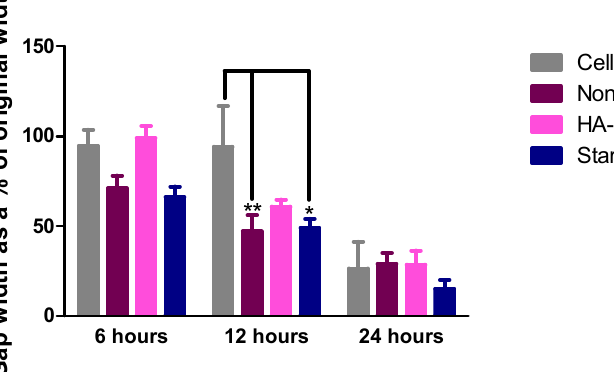
Figure 9. Cell migration assessed via gap closure achieved on a scratch assay. ( a ) Microscopy images of the gap area 12 h following addition of treatments, fresh, non-encapsulated Stromal-Derived Factor 1 α (SDF), HA–TA supernatant or SDF released from star-poly(glutamic acid) (PGA)–SDF(50:1)-HA–TA. Scale bar = 100 µ m ( b ) Quantification of gap closure showing the best gap closure achieved by star-PGA–SDF(50:1)-HA–TA supernatant. Where SDF is present the concentration is 4.1 ng/mL. ( n = 3) * p < 0.05, ** p < 0.01.